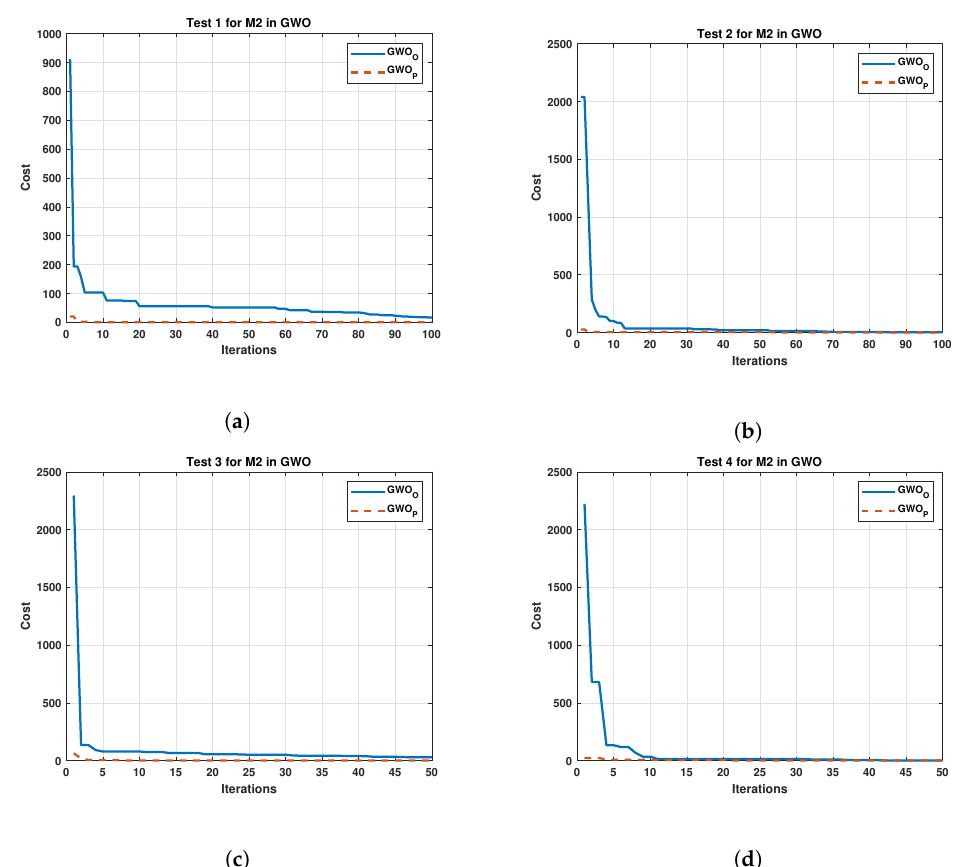
Figure 7. Comparison between the Original and Proposed Gray Wolf Optimizer in four test for Motor 2. ( a ) cost and iterations of the GWO in test 1 for Motor 2; ( b ) cost and iterations of the GWO in test 2 for Motor 2; ( c ) cost and iterations of the GWO in test 3 for Motor 2; ( d ) cost and iterations of the GWO in test 4 for Motor